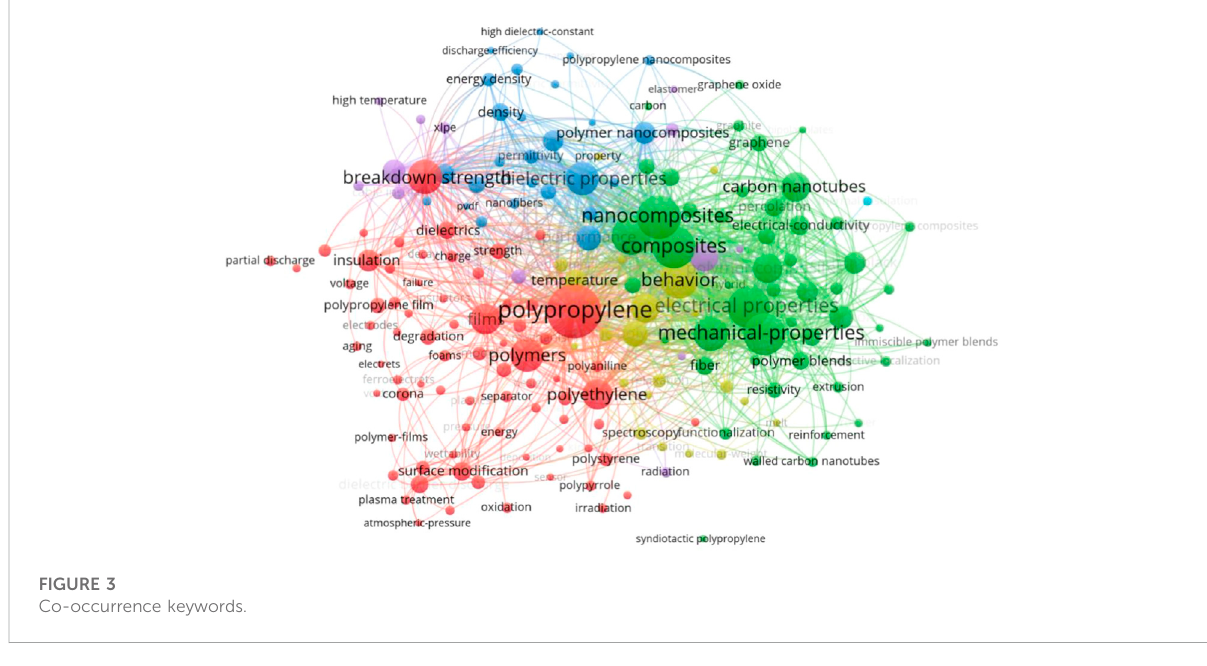
FIGURE 3 Co-occurrence keywords.